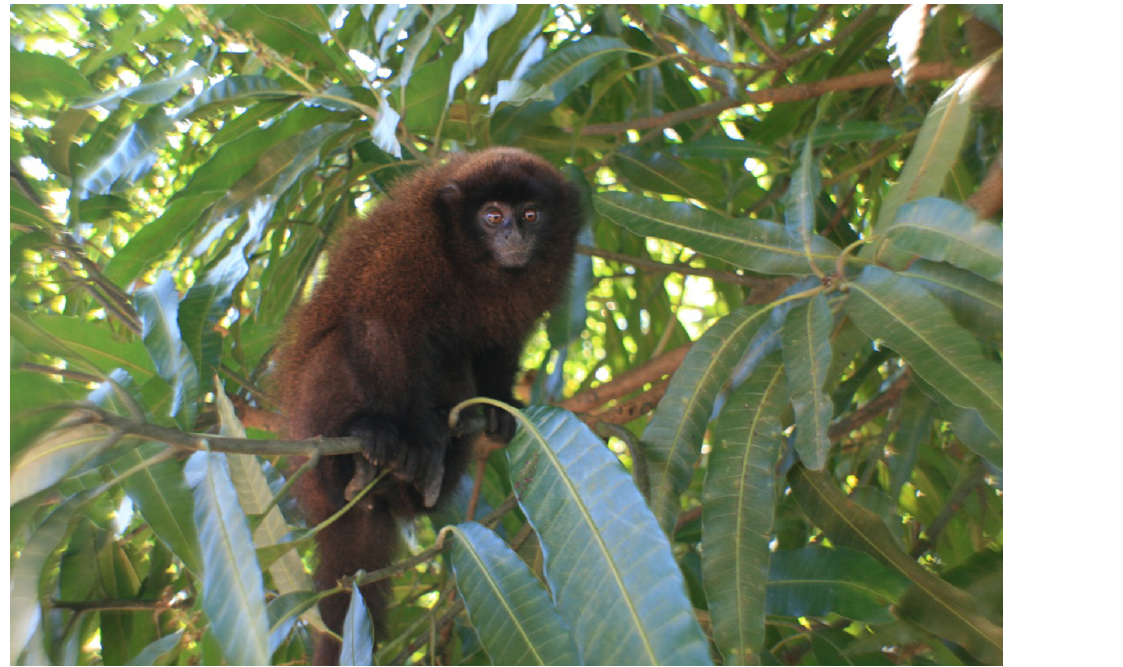
Figure 1. Juvenile member of brown titi monkey ( Plecturocebus brunneus ) study group in the urban fragment forest. Photo: Rallison